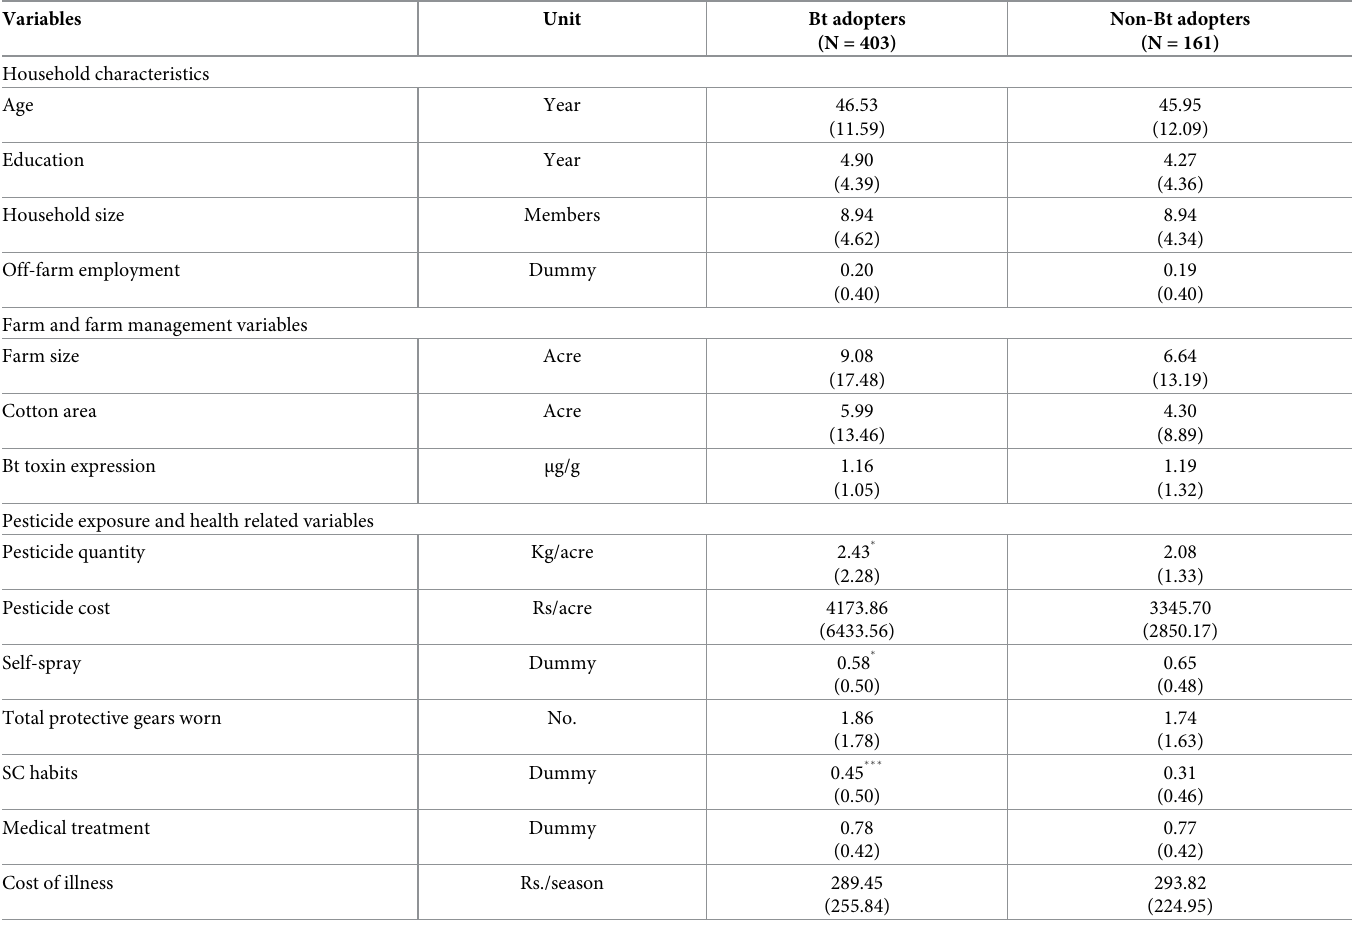
Table 2. Descriptive statistics by self-reported Bt adoption